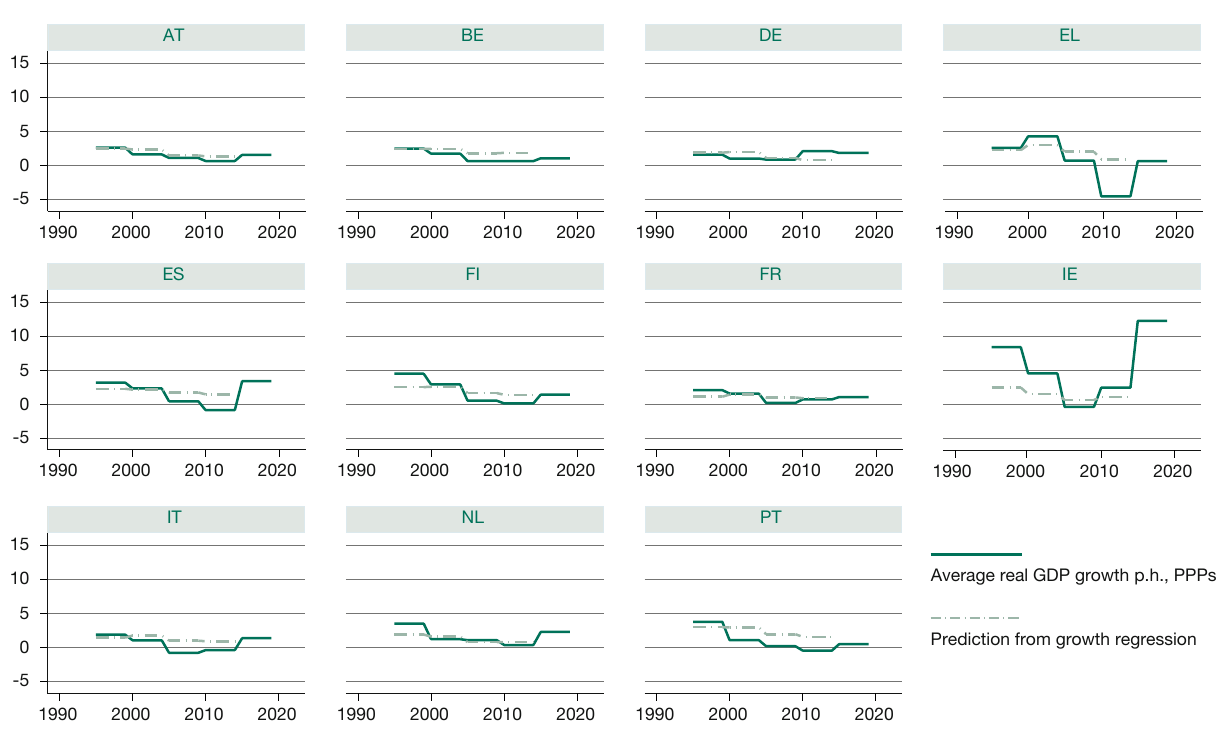
Figure 10 Actual growth rates in GDP per capita and predictions from growth